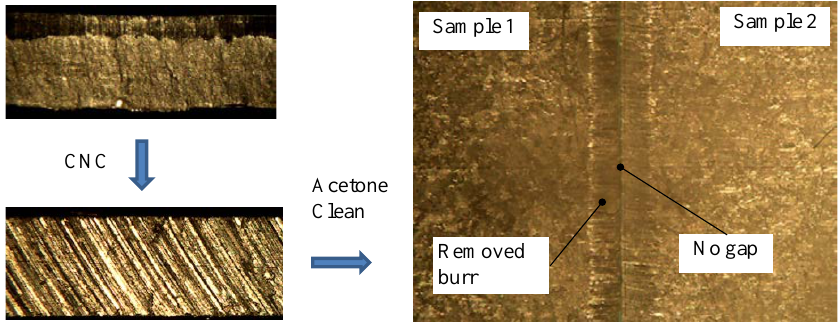
Figure 3. Cutting surface preparation for pre-welding inspection by using computer numerical control (CNC).